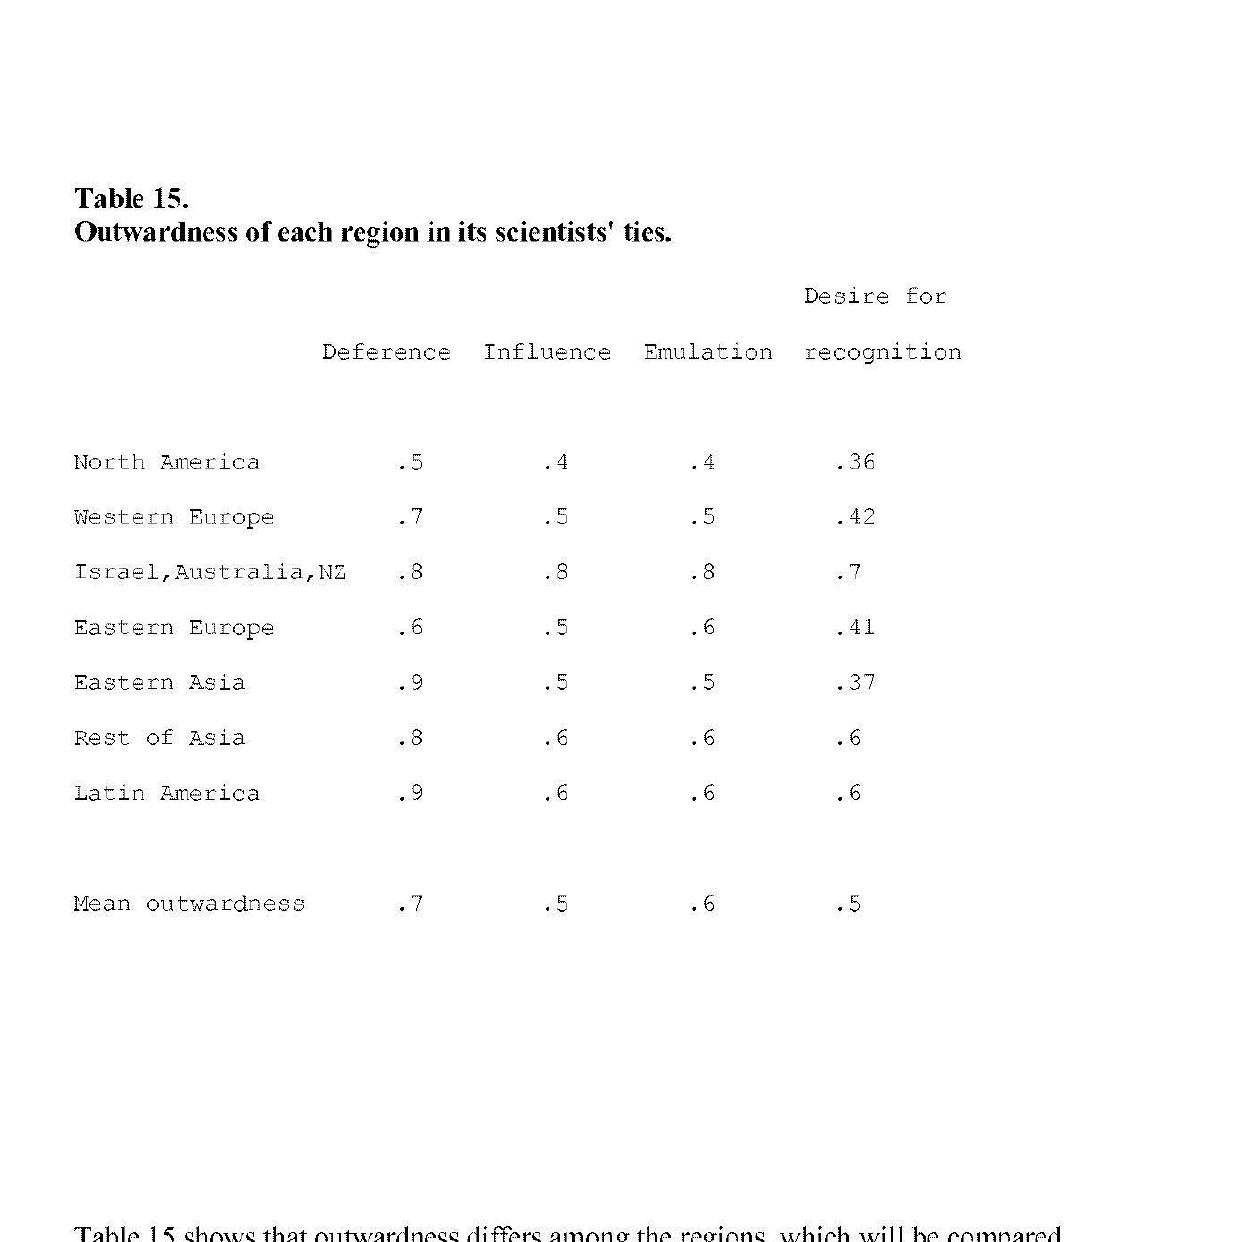
Table 15. Outwardness of each region in its scientists'